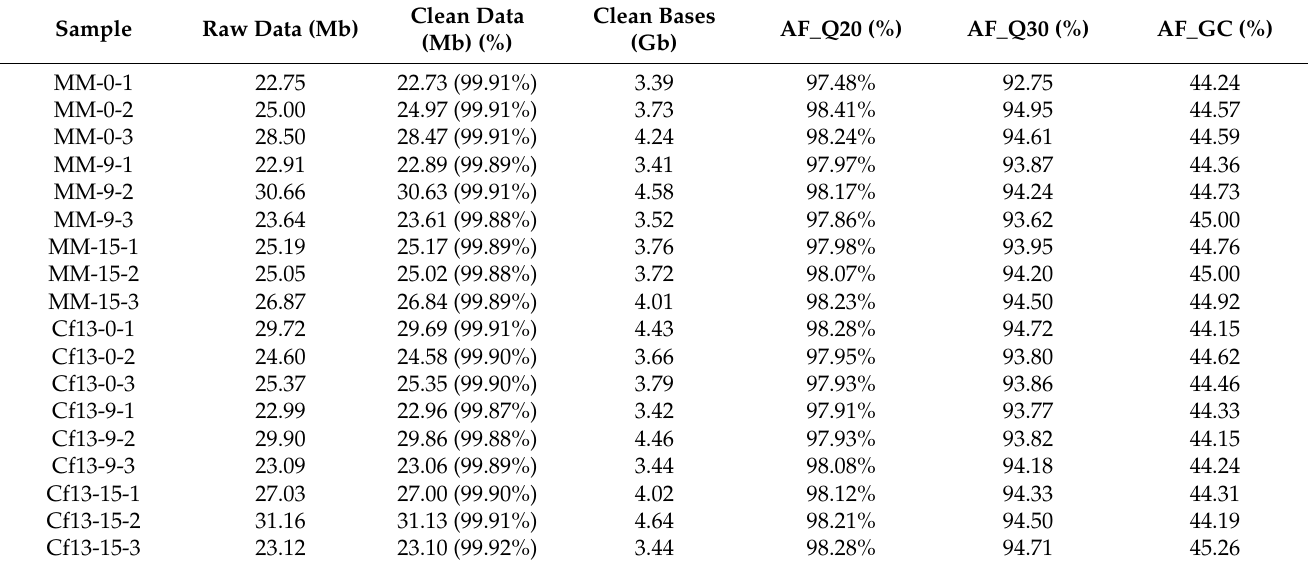
Table 1. Summary of sequencing reads after